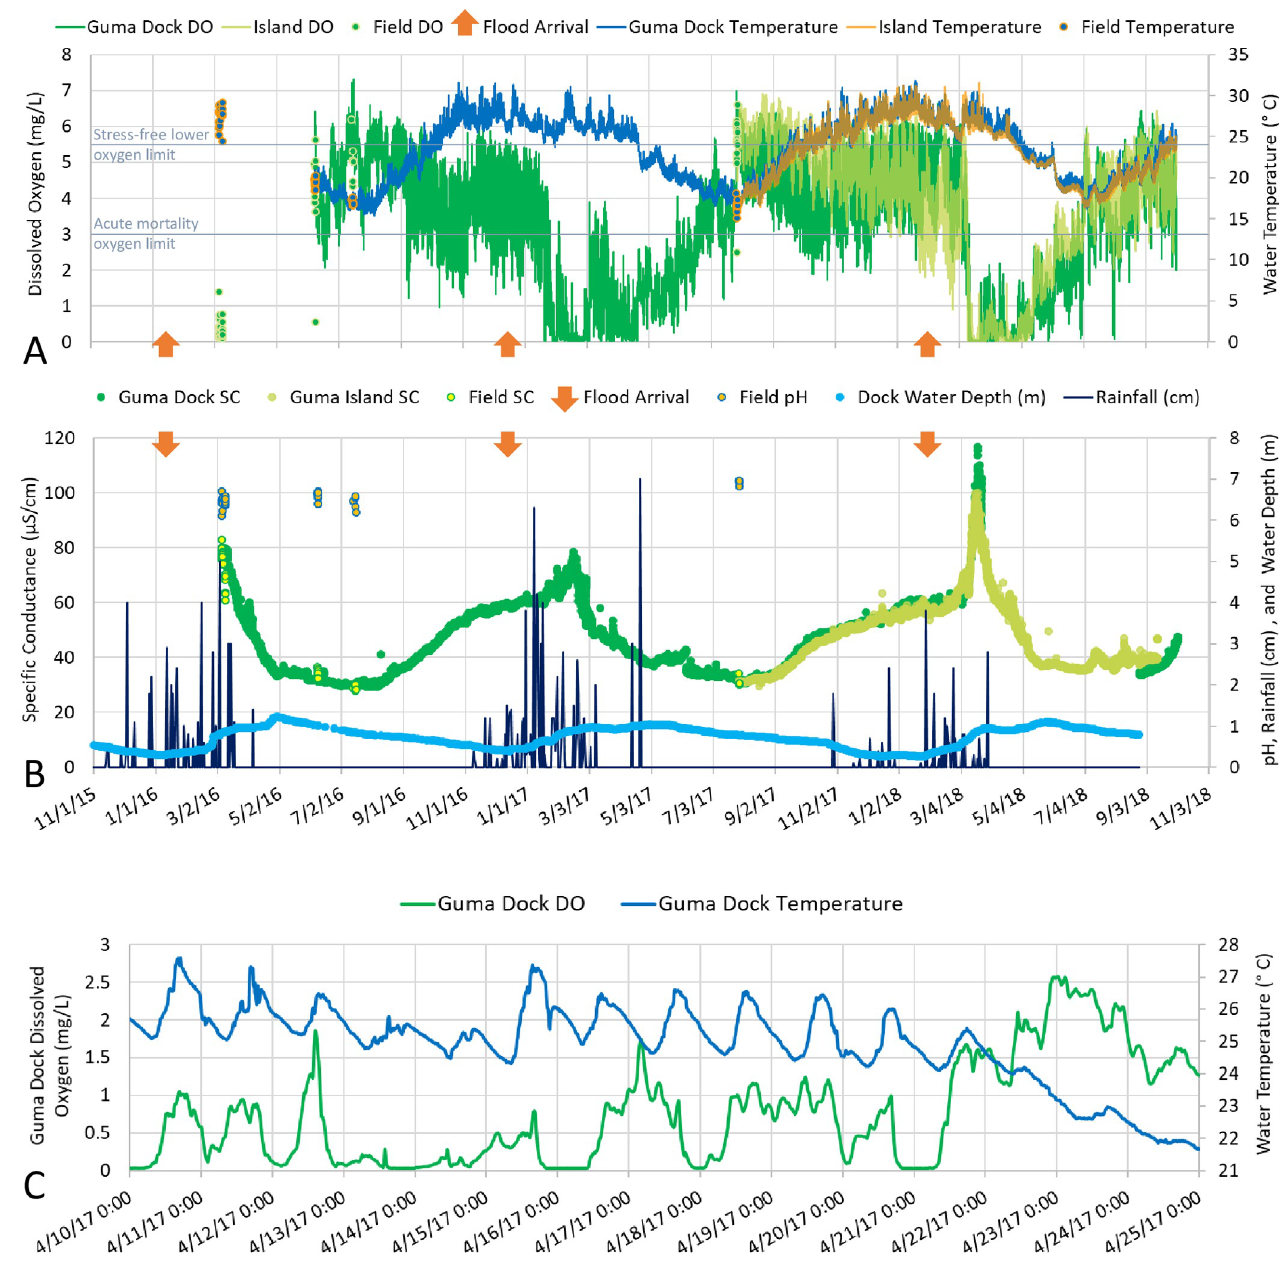
Fig 5. Abiotic conditions in Guma Lagoon. Dissolved oxygen (DO) and temperature collected with data loggers and by hand (“field”) at Guma Lagoon Camp dock and on a tree island approximately 3 km downstream on the opposite side of Guma lagoon (A). Similarly collected specific conductance (SC) and field pH are shown in (B). Orange arrows indicate flood arrival, based on first observed rise in water level. Water depth at Guma Lagoon Camp dock and rainfall (B) are monitored daily at Guma Lagoon Camp. Example daily resolution data for water temperature and DO during post-flood hypoxia (C) show that temperature followed an expected diurnal pattern with lows occurring just before sunrise and highs in the mid to late afternoon. The daily DO pattern was less predictable, sometimes tracking with temperature, but not always. At times, both peaks and troughs in DO levels were observed during the night and from midday to late afternoon. This variation suggests that photosynthesis was not the main determinant of DO. Ecosystem respiration likely outpaces photosynthesis in terms of oxygen levels during the hypoxic periods